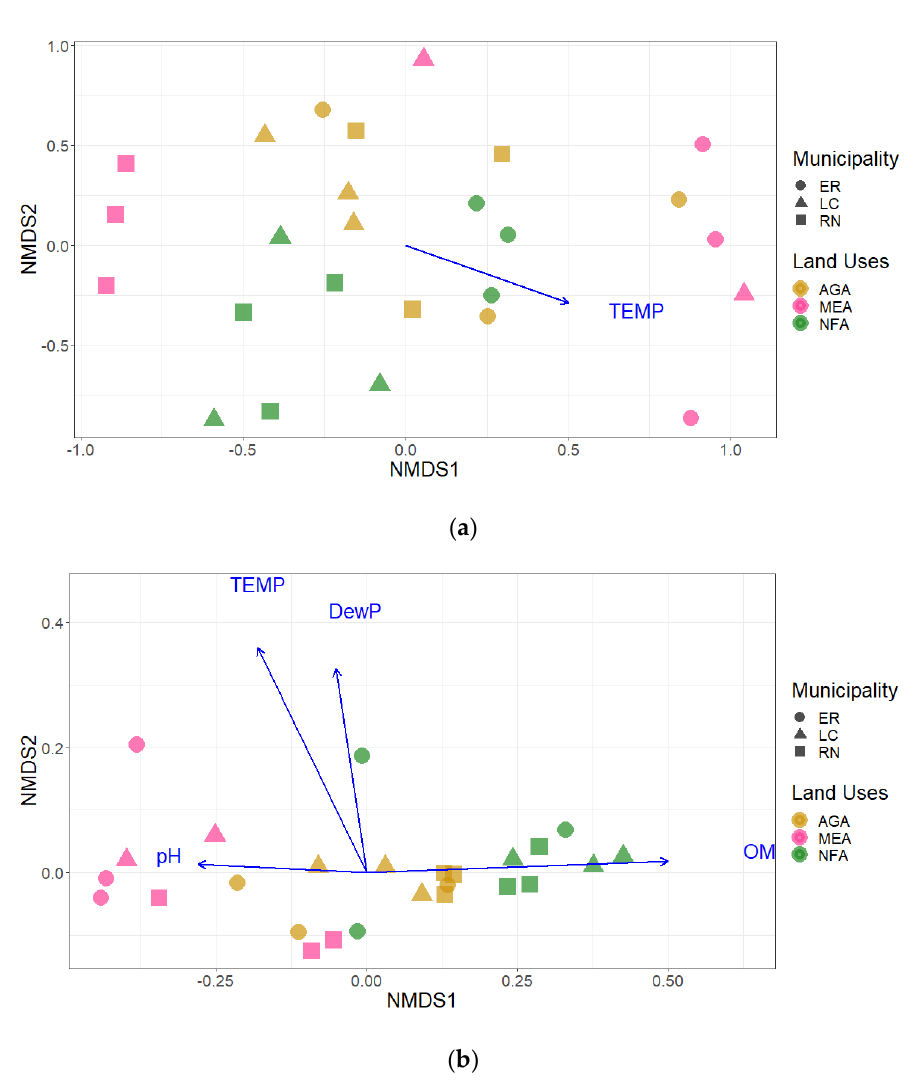
Figure 3. Non-metric multidimensional scaling of 26 soil samples with driver factors: ( a ) ordination based on order compositions (stress value = 0.243); ( b ) ordination based on alpha diversity index values (stress value = 0.027). (AGA = agricultural activities areas, MEA = mining extraction areas, NFA = natural forest areas, DewP = dew point temperature, OM = organic matter, TEMP = soil temperature).